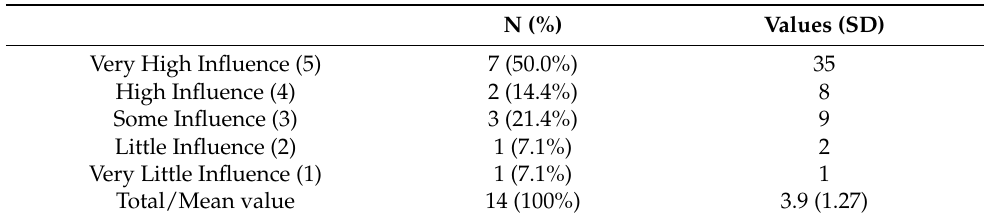
Table 3. Respondents’ Perceptions: does climate change have an influence on tourism activity in Mykonos (Q4). N (%) Values (SD) Very High Influence (5) 7 (50.0%) 35 High Influence (4) 2 (14.4%) 8 Some Influence (3) 3 (21.4%) Little Influence (2) 1 (7.1%) Very Little Influence (1) Total/Mean